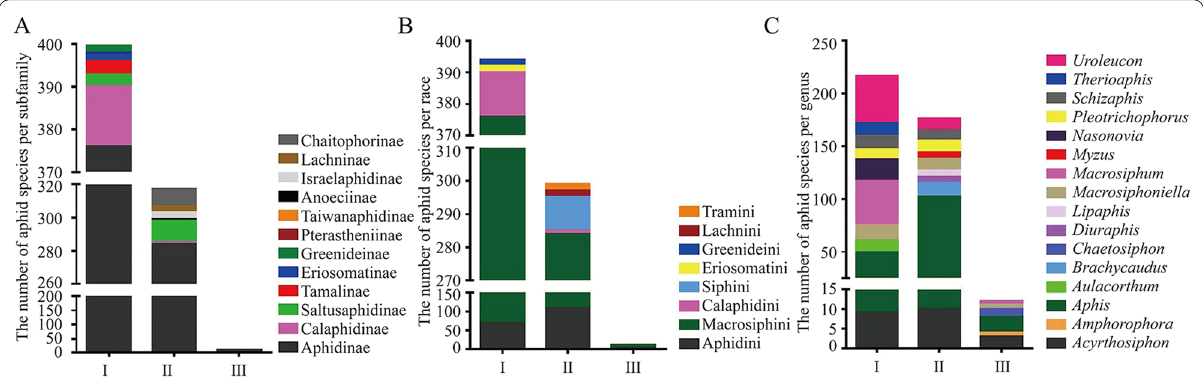
Fig. 1 Distribution of aphid species with observed male at subfamily ( A) , race ( B) and genus ( C) level. Some races are nameless and therefore not counted in the corresponding race. The statistics of genus level only the top 10 genera are showed in the figure. The male aphids with winged (alatae), wingless (apterous), and alternate wing (alatae and apterous) were defined as Class I, II,